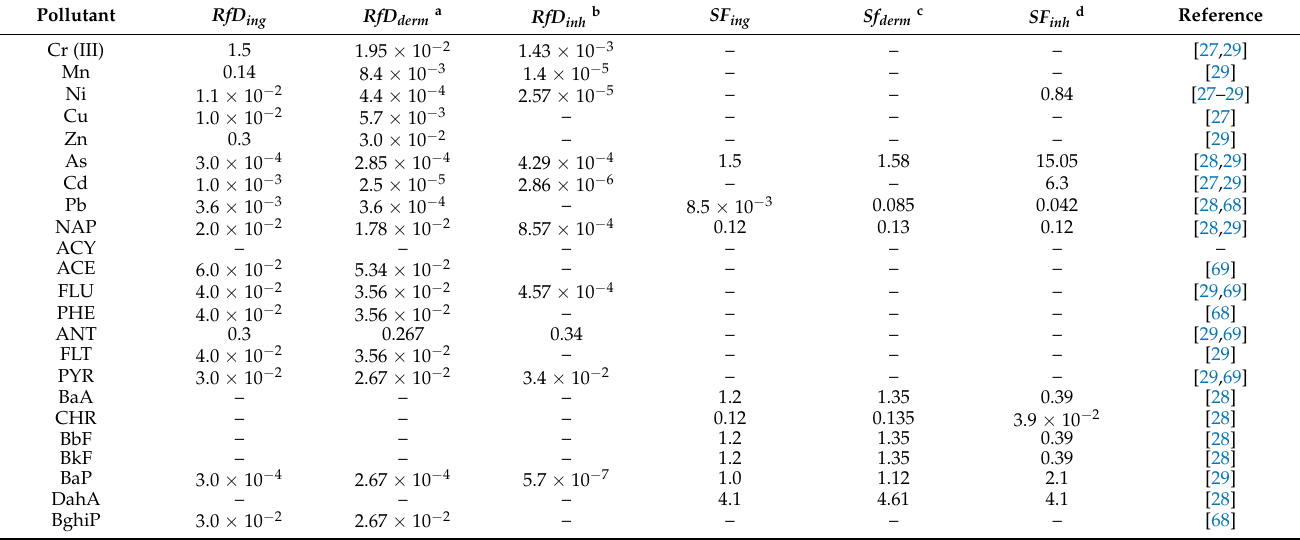
Subscripts indicate the entry paths of elements: ing —ingestion, derm —dermal contact, inh —inhalation. a RfD derm = RfD ing × ABS gi , where ABS gi is a fraction of contaminant absorbed in gastrointestinal tract: Cr 0.013, Mn 0.06, Ni 0.04, Cu 0.57, Zn, and Pb 0.1, As 0.95, Cd 0.025, and PAHs 0.89 [70]. , where RfC is a reference concentration [59]. c SF derm = ABS gi is a fraction of contaminant absorbed in gastrointestinal tract [70]. d SF inh = where UR is a risk per unit content of the substance